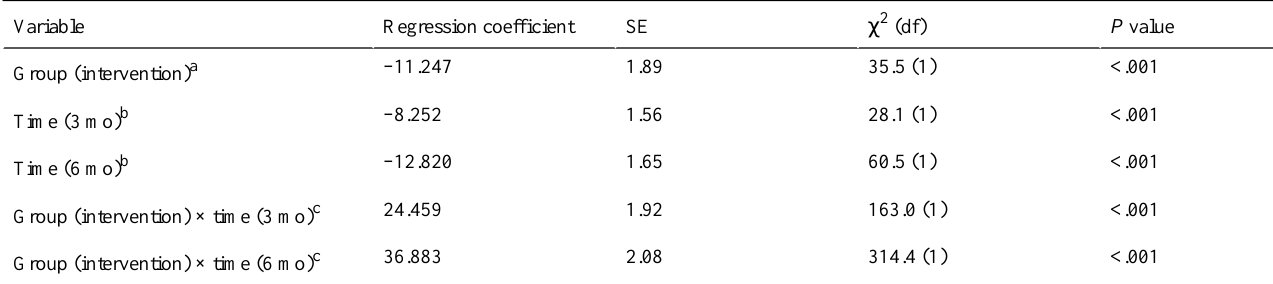
Table 5. Generalized estimating equation analysis of the effect of the intervention on self-rated health